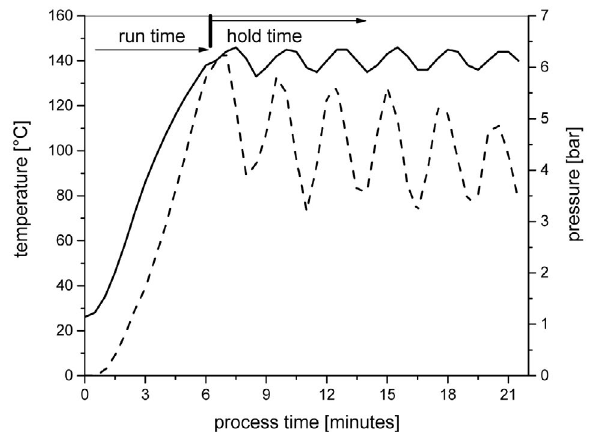
Figure 2. Process temperature and process pressure as a function of the process time. In this example the set temperature is 140 °C and the process duration is 15 min. This set temperature is reached after a run time of around 6